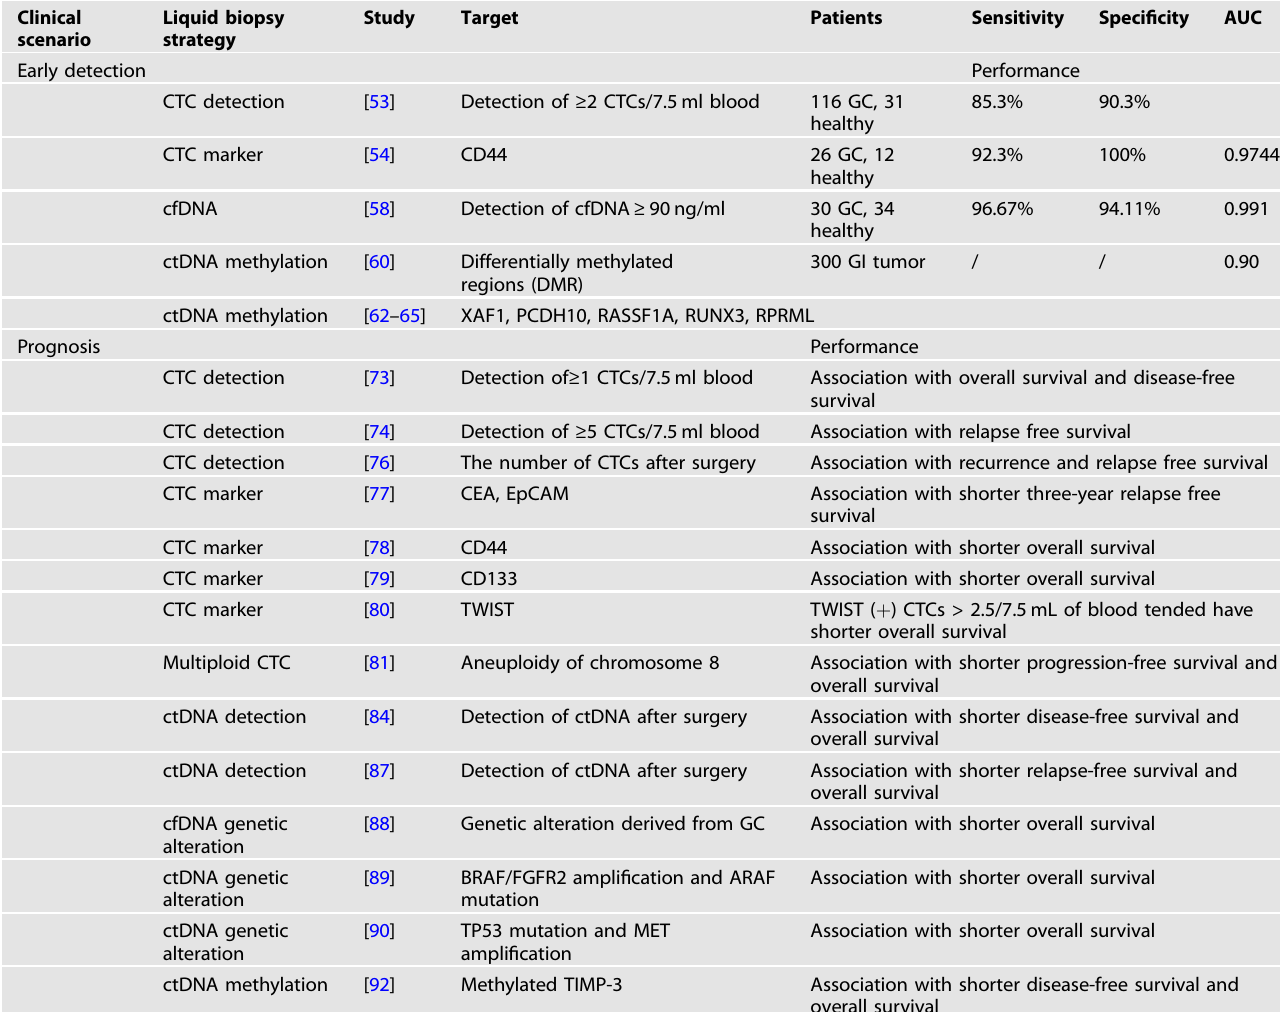
Table 1. Liquid biopsy of CTCs and ctDNA/cfDNA in